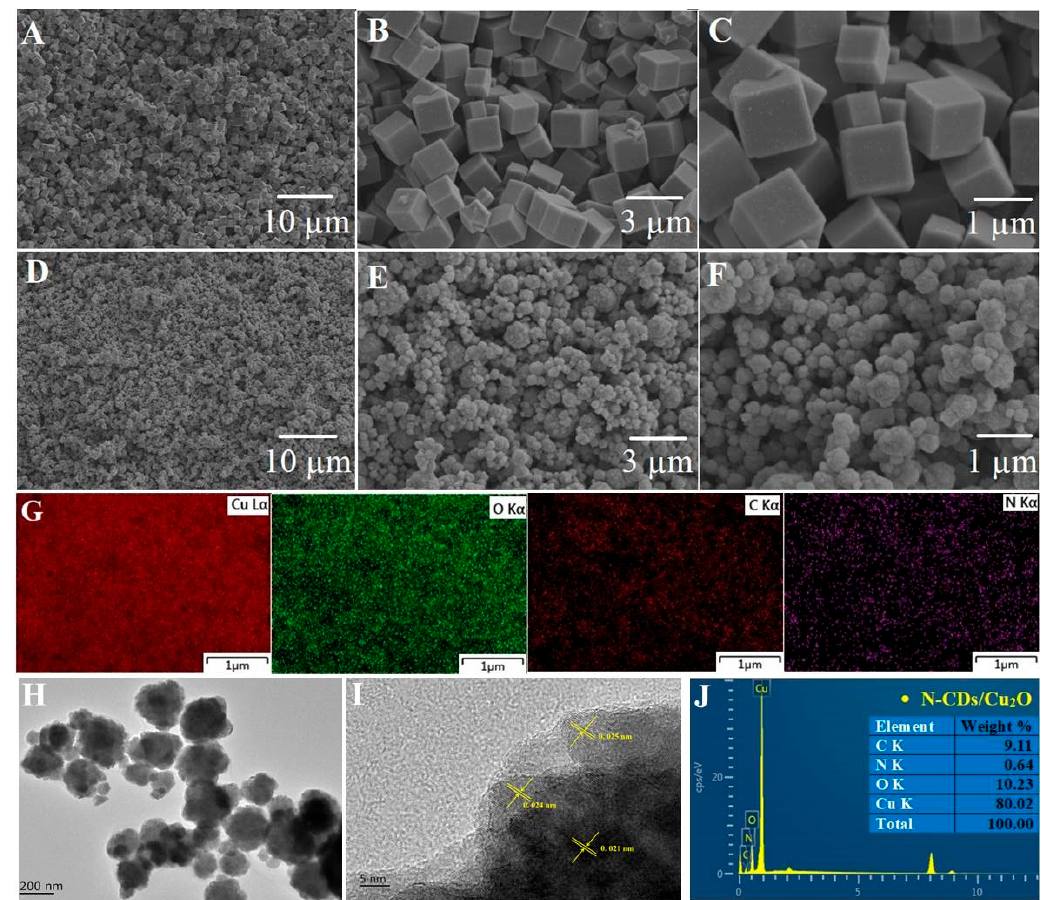
Figure 1. ( A – C ) SEM images of Cu 2 O, ( D – F ) N-CDs/Cu 2 O composite, ( G ) elemental mapping of N-CDs/Cu 2 O composite, ( H ) TEM, ( I ) its corresponding high resolution transmission electron microscopic (HRTEM) image of N-CDs/Cu 2 O and ( J ) elemental composition of N-CDs/Cu 2 O composite.